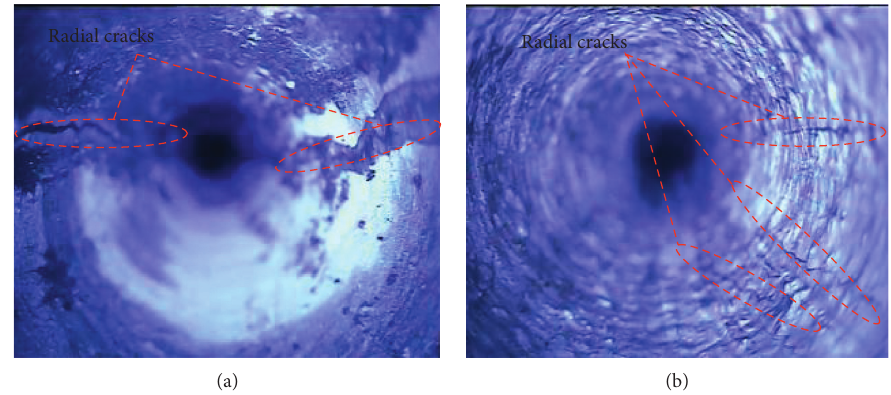
Figure 12: The peep results from the No. 7 monitor station: (a) 30cm; (b) 83